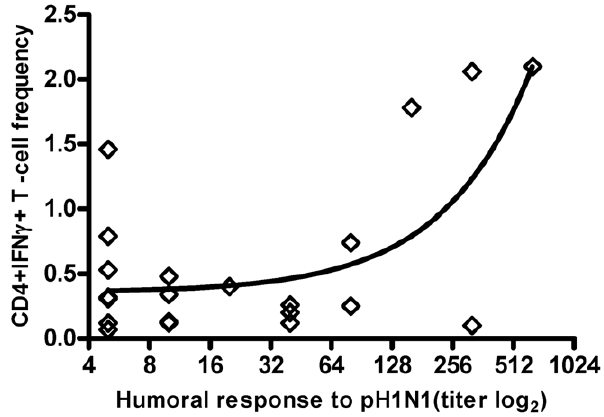
Figure 3. Relationship between CD4 + IFN c T-cell frequency (%) and the humoral response (n=19). (R 2 =0.428,